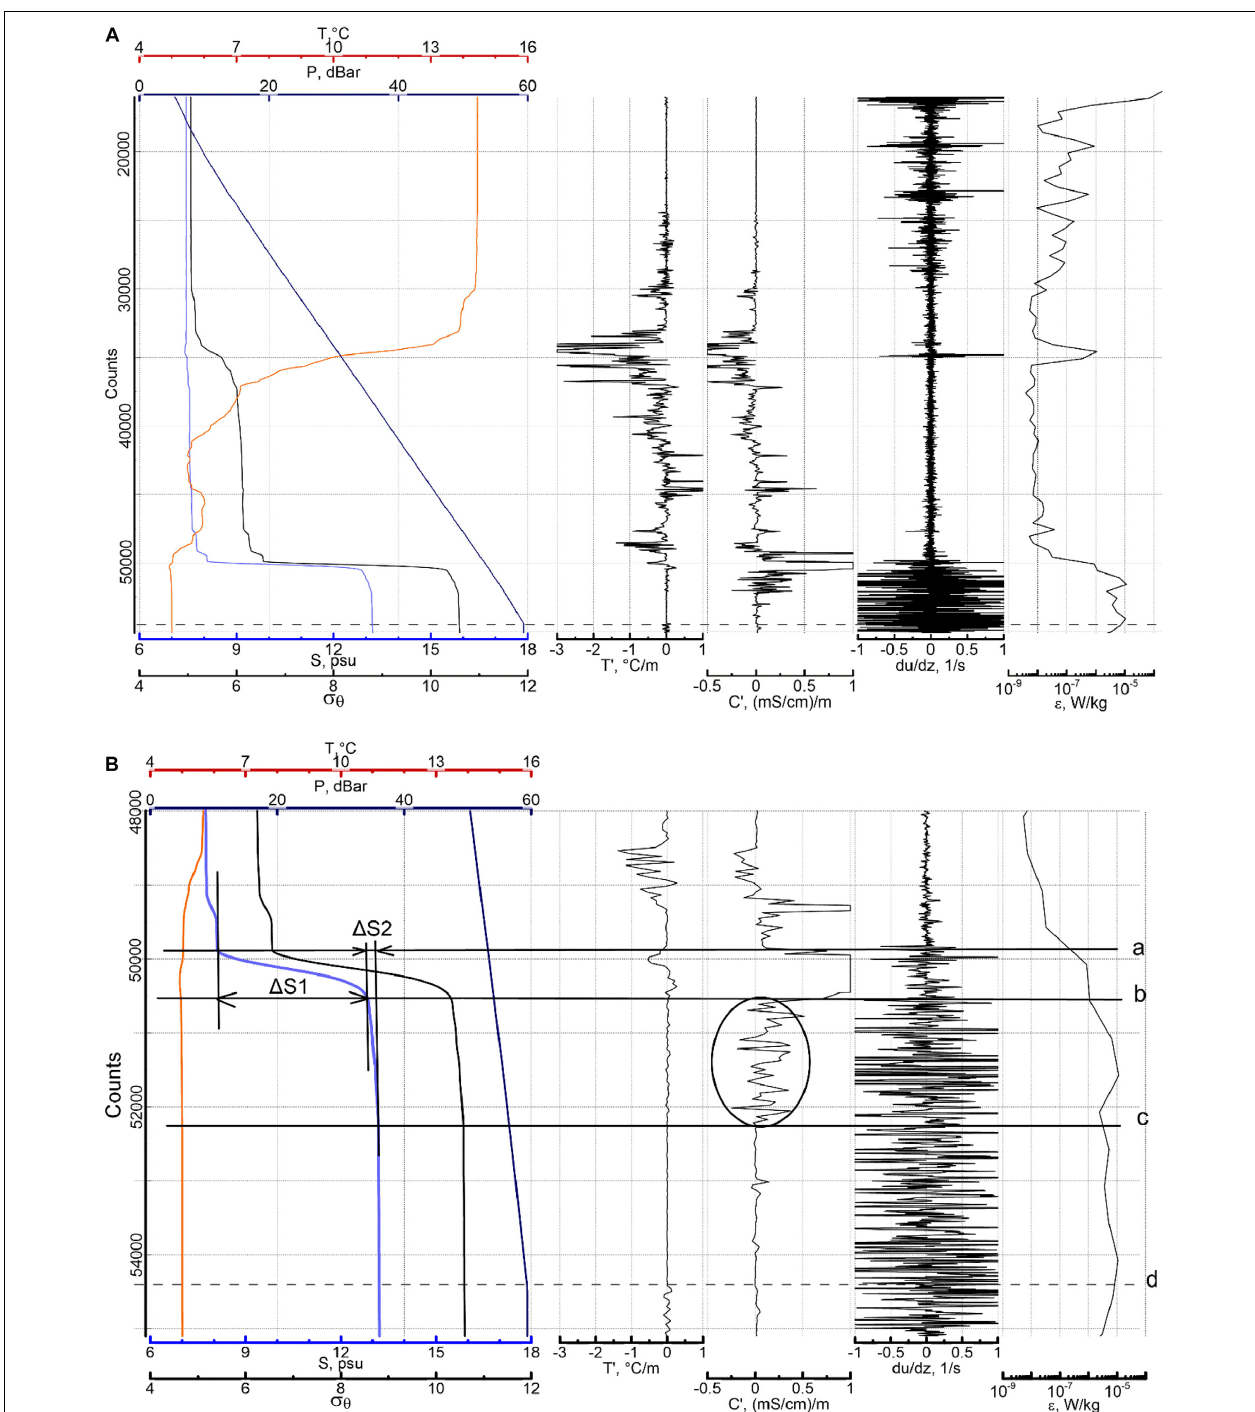
FIGURE 10 | (A) Example of turbulent bottom layer on the Słupsk Sill, the profile was registered on 02.07.2017, 19:40 at the following position: 55 ◦ 13.167 (cid:48) N, 16 ◦ 33.423 (cid:48) E. A westerly wind of 5–15 m/s prevailed. On the left panel: temperature T, ◦ C; salinity S, psu; density σ θ , pressure P, dBar. On the next panels from left to right: microstructure of temperature T (cid:48) , ◦ C/m and conductivity C (cid:48) , (mSim/cm)/m; shear velocity fluctuations du/dz, 1/s; dissipation rate ε , W/kg. Dashed line marks the moment when the probe reaches the seabed and the pressure signal becomes constant. (B) Zoomed fragment of the profile shown in (A) presenting the fine- and micro- structures of the salt/dense bottom layer. Horizontal solid lines show upper bounds of (a) high gradient sheet, (b) moderate gradient sublayer (entrainment layer), (c) homogeneous sublayer; dashed line (d) marks the end of profiling. Ellipse marks a segment of developed conductivity microstructure. Crossing of the salinity plot with vertical lines show where salinity increments (cid:49) S1 = 4.68 psu and (cid:49) S2 = 0.29 psu were evaluated.